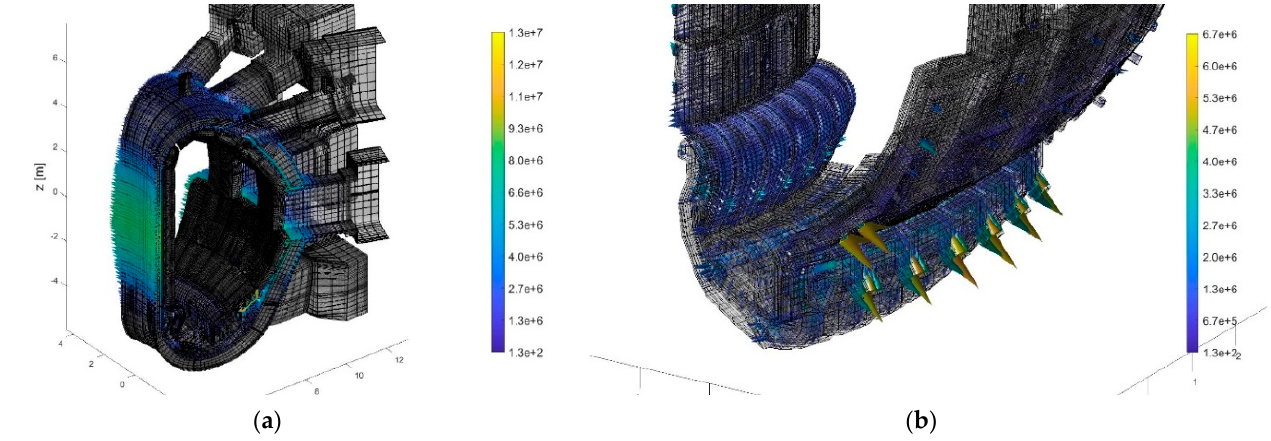
Figure 17. Testcase#2. Mesh ( a ) and pictorial representation of the current density ( b ).